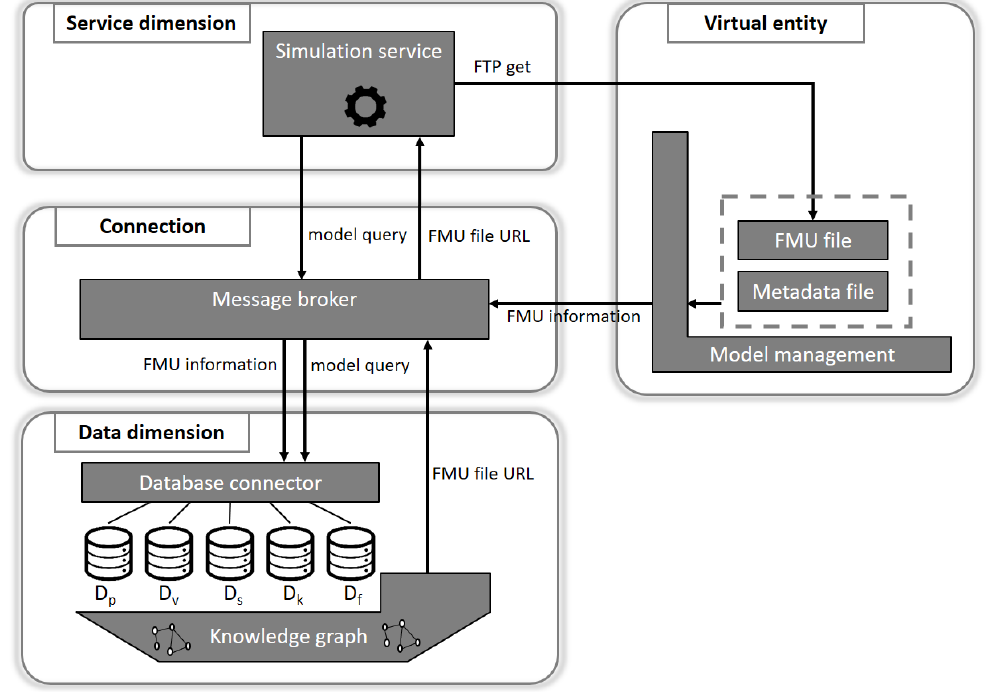
Figure 4. An exemplary service (simulation service from Figure 3) queries for a specific model instance within the virtual entity of the DT platform. The knowledge graph provides its access